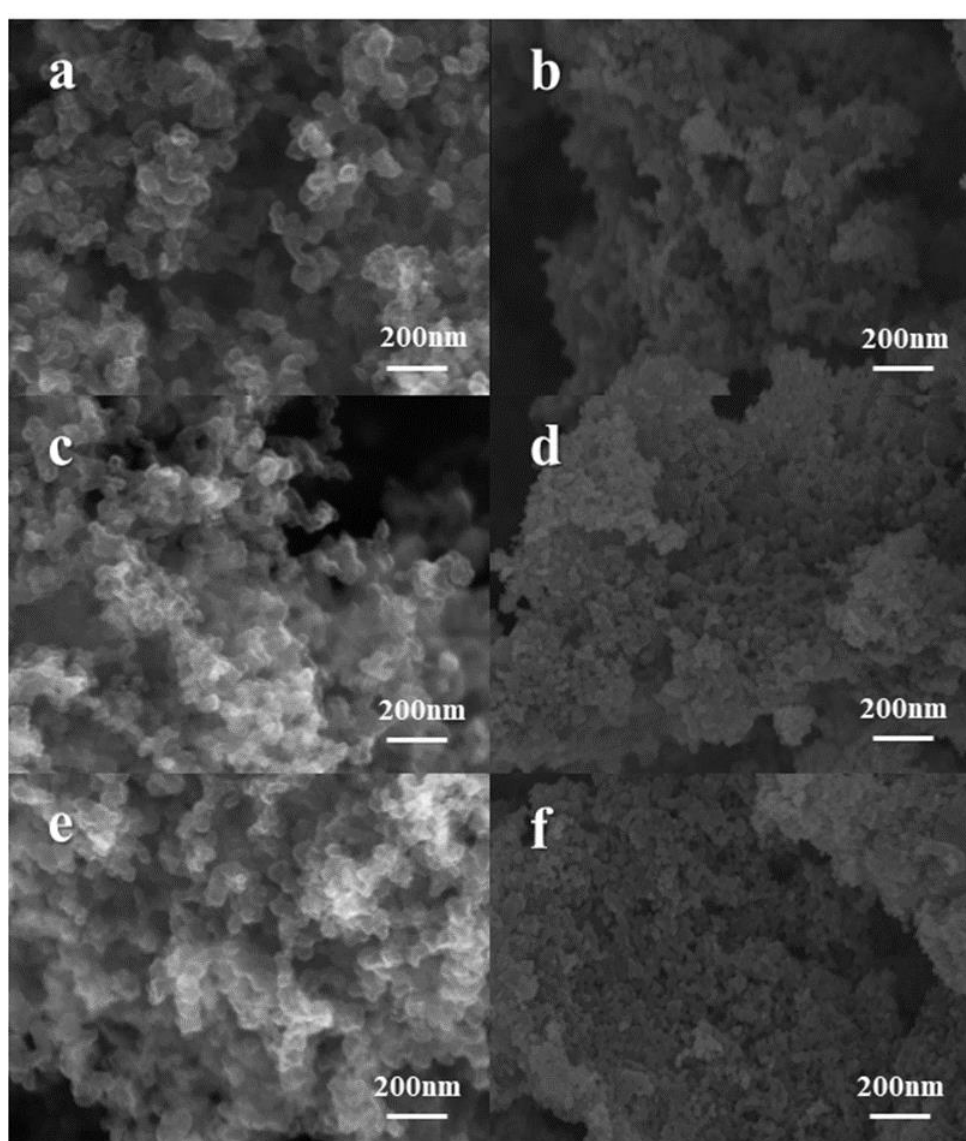
Figure 2. SEM morphology of BN/KB materials at different temperatures and morphology after loading S ( a ) 150 °C BN/KB ( b ) 150 °C BN/KB ( c ) 175 °C BN/KB ( d ) 175 °C BN/KB ( e ) 200 °C BN/KB loading S ( a ) 150 ◦ C BN/KB ( b ) 150 ◦ C BN/KB ( c ) 175 ◦ C BN/KB ( d ) 175 ◦ C BN/KB ( e ) 200 ◦ C ( f ) after load S BN/KB ( f ) 200 °C BN/KB after load S. BN/KB ( f ) after load S BN/KB ( f ) 200 ◦ C BN/KB after load